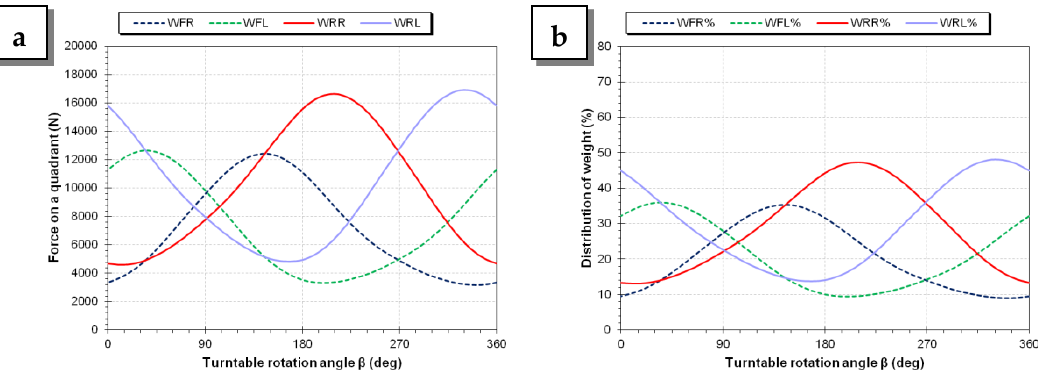
Figure 21. ( a ) forces normal to the four quadrants that support the vehicle during a complete rotation of the turntable for α = 20.00°; ( b ) percentage decomposition of the total weight on the four quadrants/wheels for α = 20.00°.